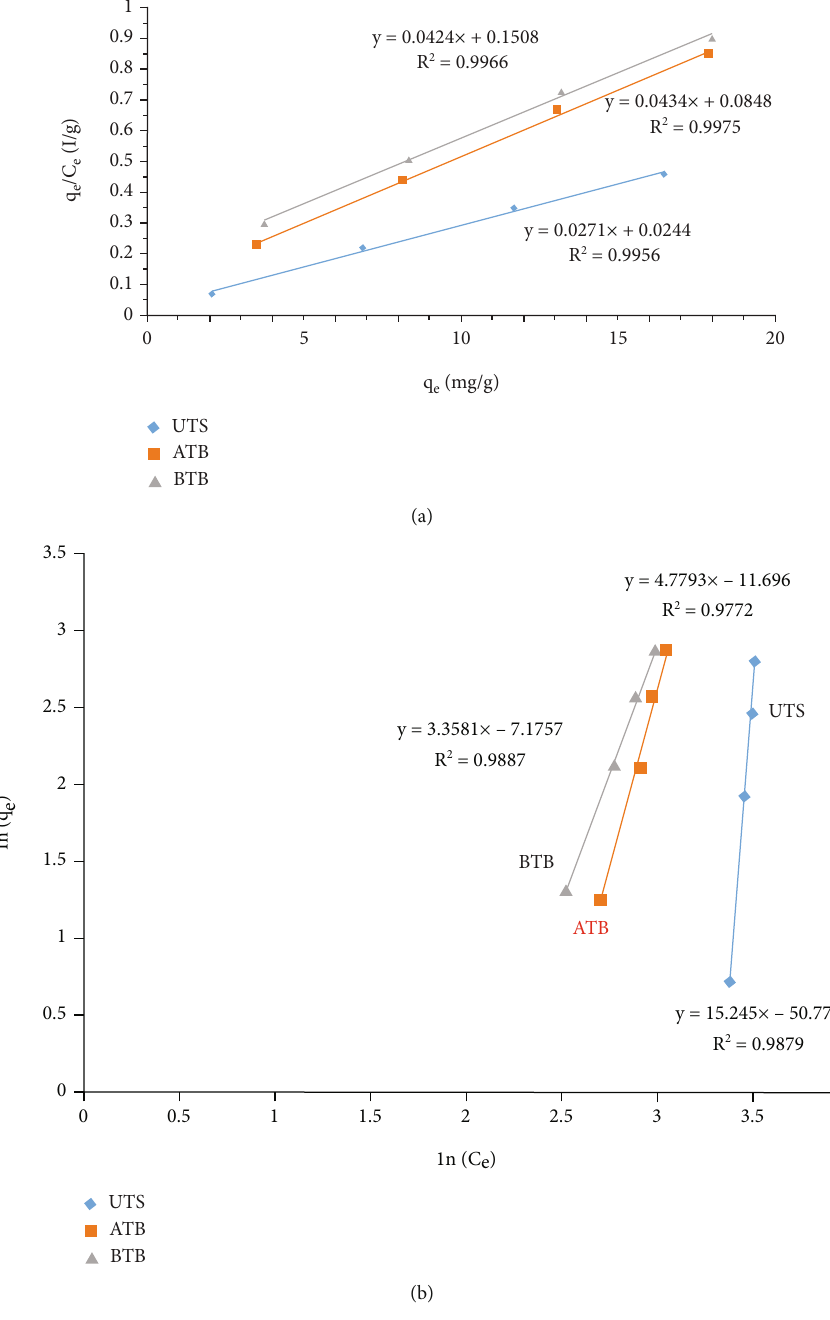
Figure 9: Linear fi tting for adsorption of Cr (VI) metal ion: (a) Langmuir isotherm and (b) Freundlich